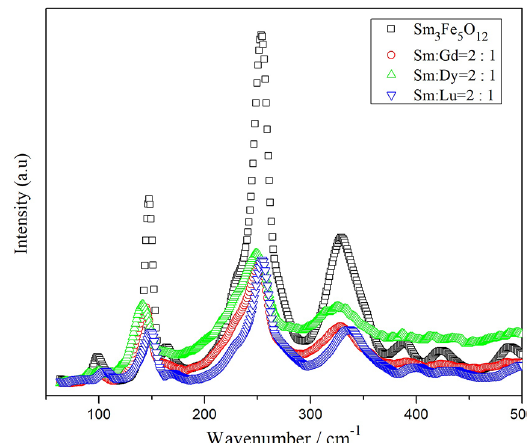
Figure 12. Raman spectra of garnet-system Sm x = 0.0, 0.1, 0.2, 0.4, 0.6, 0.8 and 1.0.